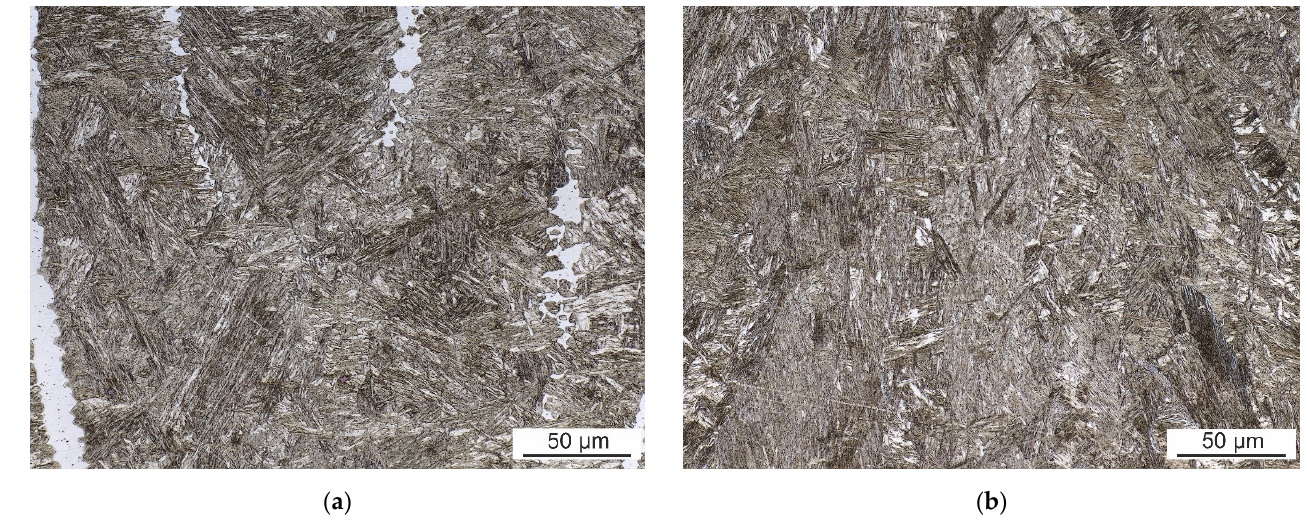
Figure 8. FZ of ( a ) laser weld and ( b ) hybrid weld made with 60 A.